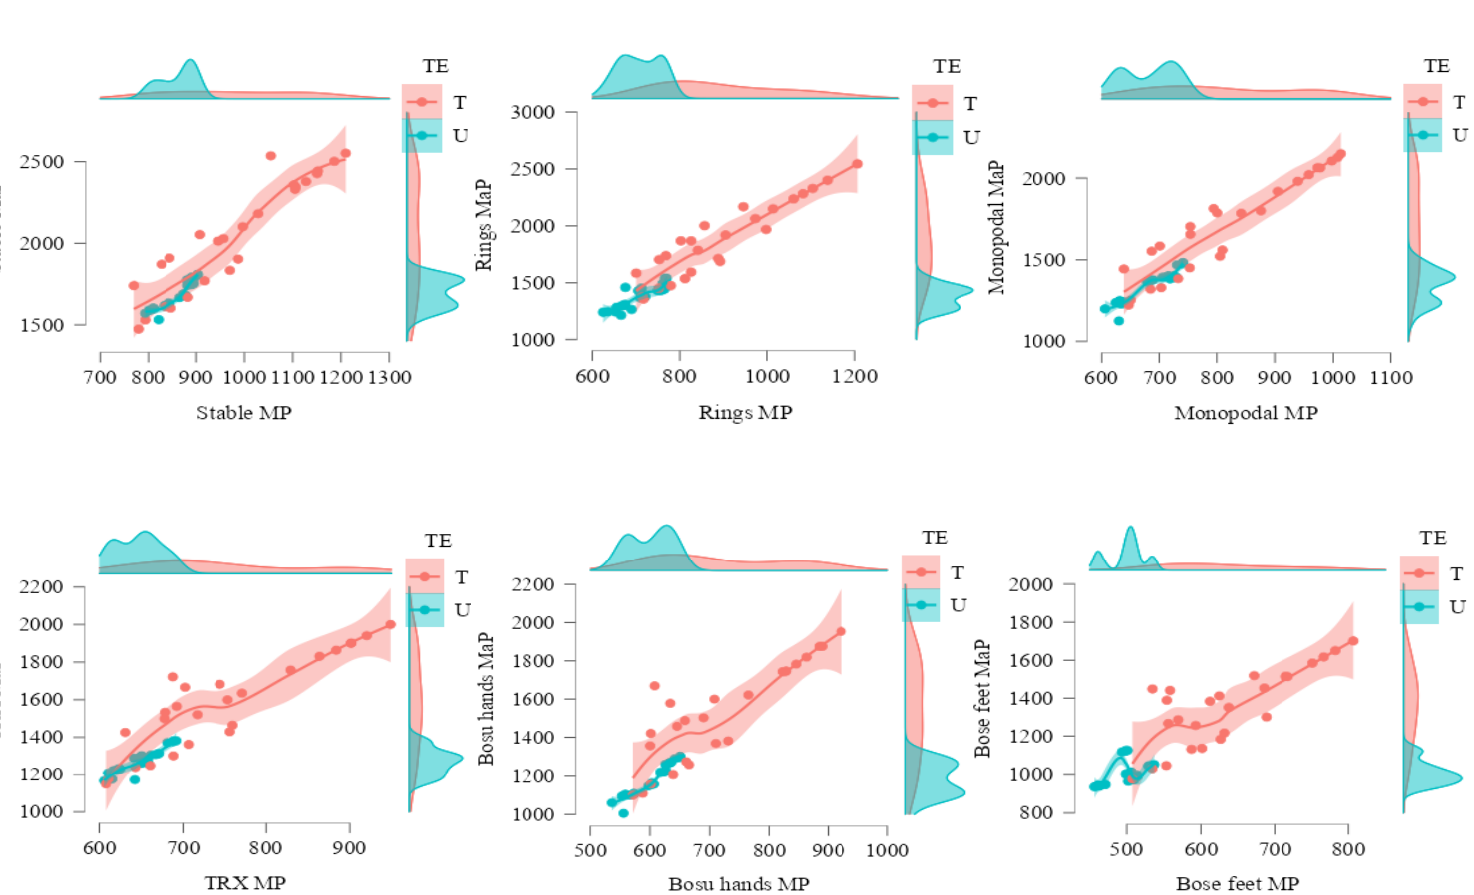
Figure 3. Mean power (MP) and maximum power (MaP) in the push-up exercise for untrained (U) and trained (T) groups based on experience (TE) for unstable performance tasks, measured in watts. Notes: The figure shows the two variables analyzed in each execution. On the X axis the values of mean power and on the Y axis the values of maximum power. The colors show the different groups: trained in pink and untrained in blue. The dots represent the values of the subjects and the dispersion. A line representing the trend has also been added and the colored areas are the confidence intervals. On both axes, the density of the points according to the categorization of the subjects is also represented.